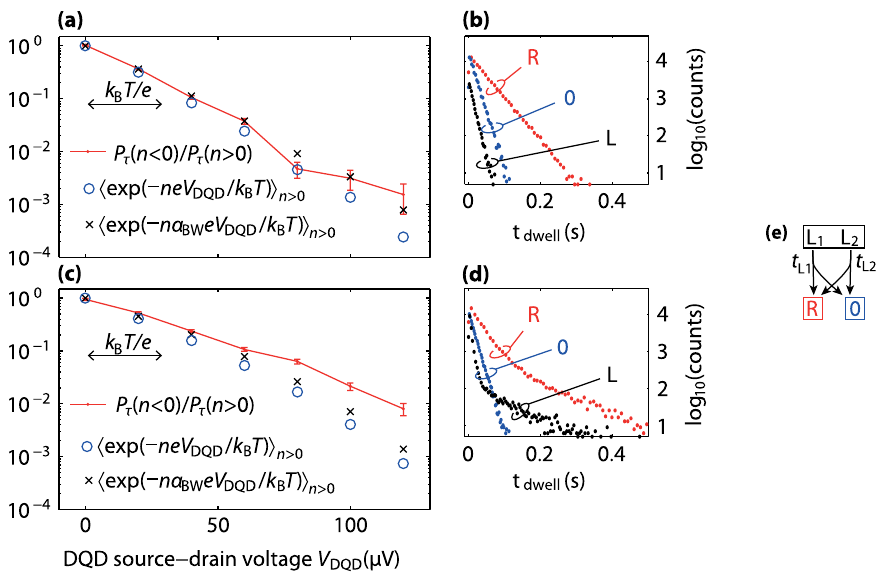
FIG. 3. (a) The red data points show the V DQD dependence of the left-hand side of Eq. (4), which is the ratio of entropy-consuming vs entropy-producing cycles, with error bars that indicate its estimated standard deviation. The blue circles show the right-hand side, which is the average of the Boltzmann factor among the entropy-consuming cycles. The FT [Eq. (4)] is satisfied if the finite detector bandwidth is taken into account in the form of a correction factor (cid:3) BW to the exponent in Eq. (4) (shown as crosses). The uncertainty in the finite-bandwidth correction is comparable to the error in P (cid:1) ð n < 0 Þ =P (cid:1) ð n > 0 Þ for all bias voltages. (b) Dwell-time distributions of the G QPC signal in the states L, R, and 0, as extracted from the data set in (a) at the point V DQD ¼ 0 (cid:2) V . (c) and (d) Same as (a) and (b), but measured at a slightly different gate-voltage configuration. In this case, the dwell times at zero bias (d) are nonexponentially distributed for the states L and R. The finite-bandwidth model [the crosses in (c)] is not valid for this case but plotted for comparison. (e) Diagram of the decay of a single-charge state L (black rectangle) that consists of two internal QD states L1 and L2. Such a process can lead to nonexponentially distributed charge-dwell times as shown in